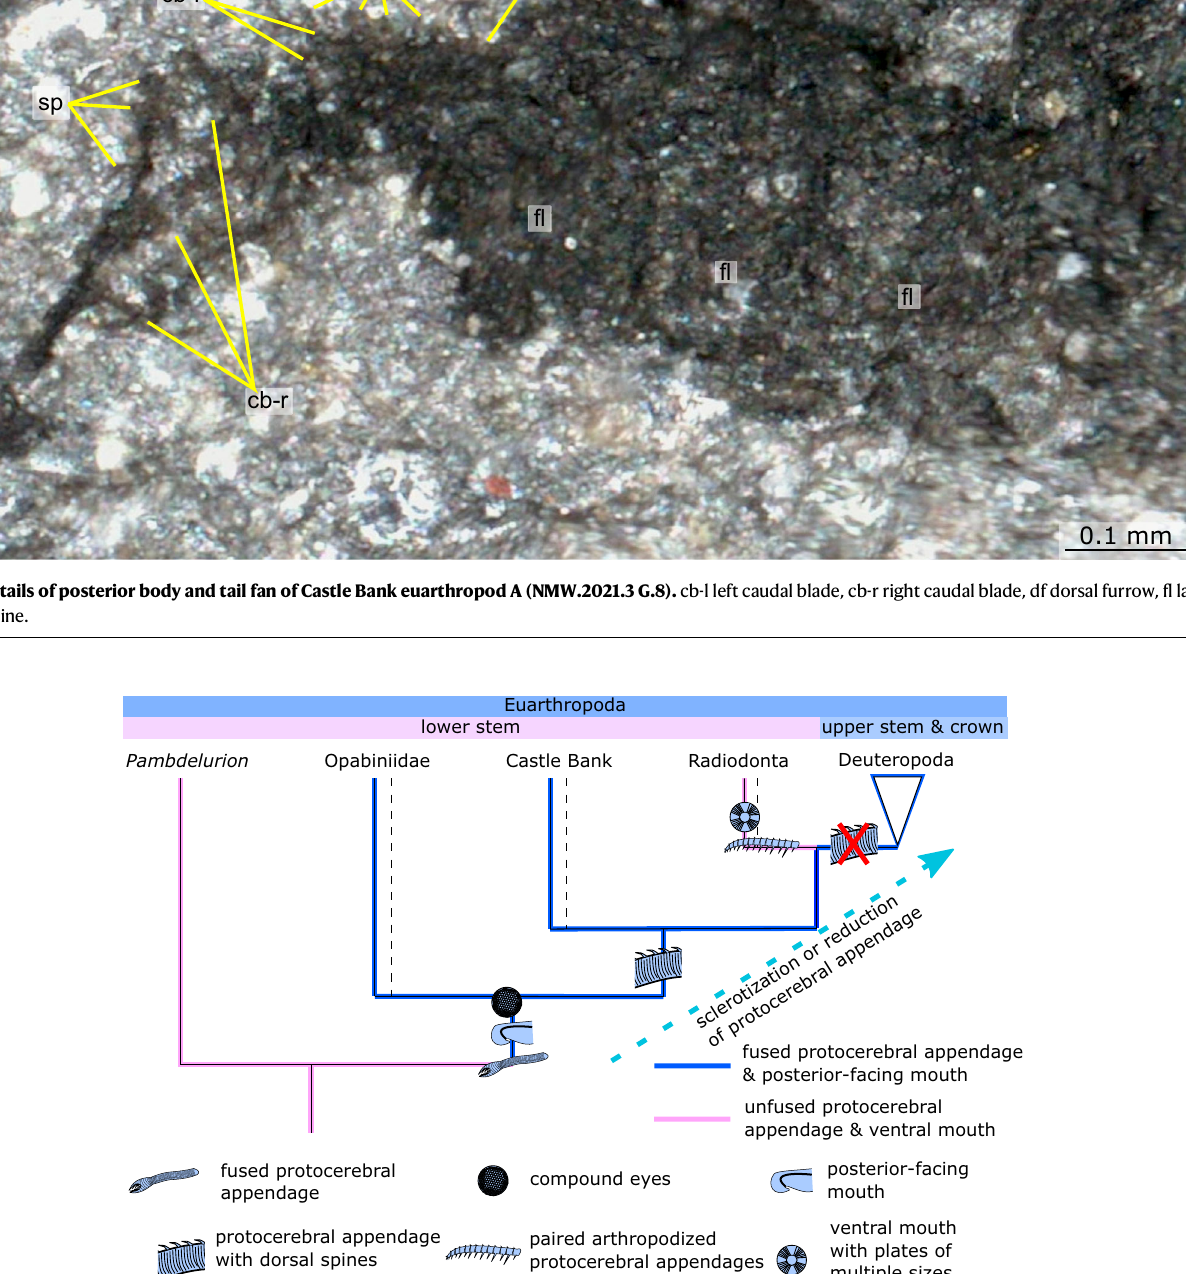
Fig. 10 | Simpli fi ed results ofphylogenetic analyses and a putativepathway of evolution of key head characters within the euarthropod lower stem group. Dotted lines indicate nodes where some analyses resolved polyphyletic or